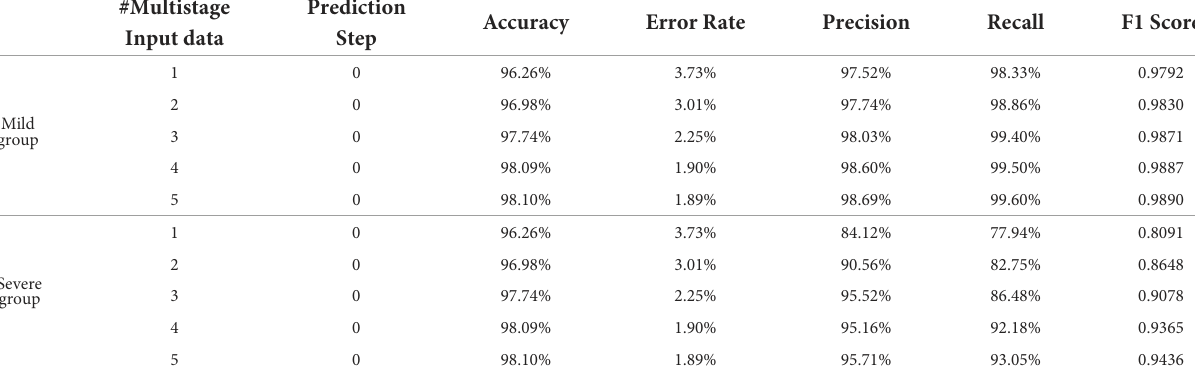
TABLE 2 Performance comparison of MMDL model with different numbers of multistage inputs.